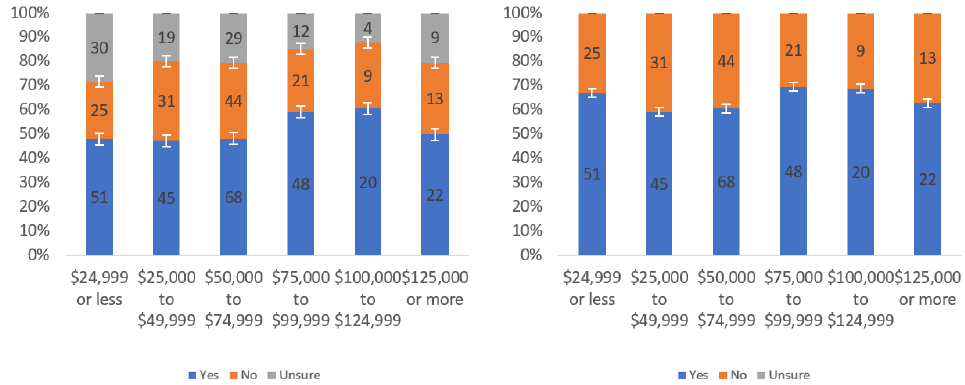
Figure A28. Responses regarding usefulness in judging trustworthiness by income level including ( left ) and excluding ( right ) unsure responses.